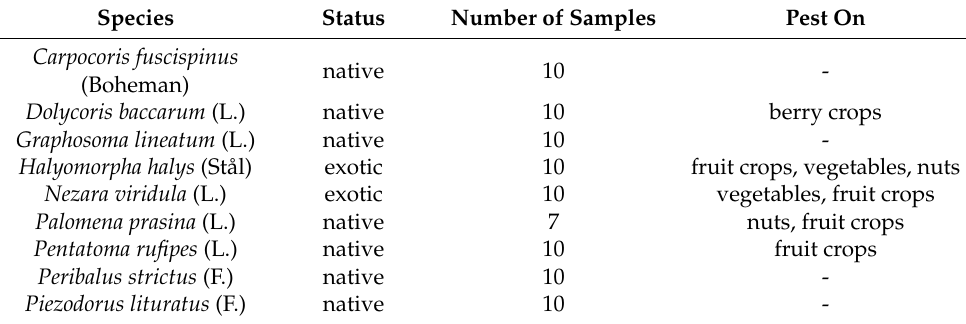
Table 1. Stink bug species and samples used in the current study. Species Status Number of Samples Pest On Carpocoris fuscispinus native 10 - (Boheman) Dolycoris baccarum (L.) native 10 berry crops Graphosoma lineatum (L.) native 10 - Halyomorpha halys (Stål) exotic 10 Nezara viridula (L.) exotic vegetables, fruit crops Palomena prasina (L.) native nuts, fruit crops Pentatoma rufipes (L.) native 10 fruit crops Peribalus strictus (F.)